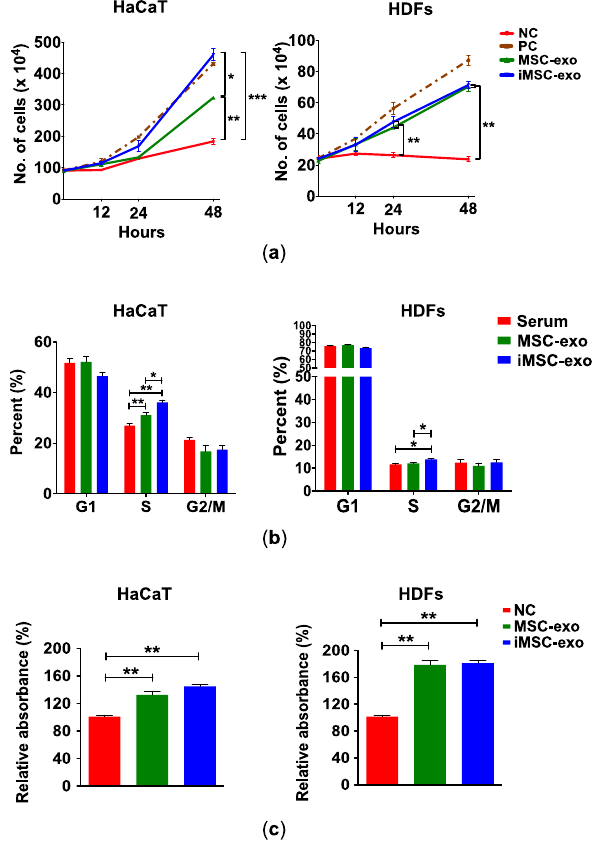
Figure 3. Growth kinetics, cell cycle, and survival analyses of skin cells treated with exosomes. Exosomes collected from MSCs (MSC-exo) or iMSCs (iMSC-exo) were incubated with HaCaT (left) or HDFs (right). ( a ) Growth profile was measured in exosome-treated cells at designated study points. Negative control (NC) is cells from serum-free culture. Culture with serum (10%) was used as positive control (PC). ( b ) At 48 h of treatment, the percentage of cells in each cycle was measured by flow cytometry. Cells cultured in serum (10%) were used as positive control. ( c ) Cell proliferation analysis by MTT assay. At 48 h of exosome treatment, the absorbance of final precipitates was measured at a wavelength of 570nm, and normalized against the value obtained from serum-free negative control (NC). All data are expressed mean ± standard deviation (SD) from three replications. * p < 0.05, ** p < 0.01, and *** p < 0.005.